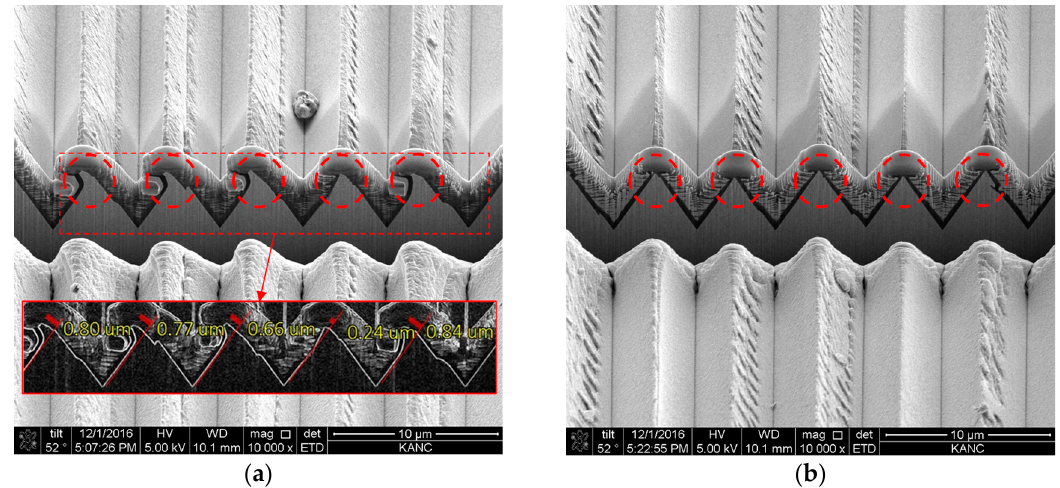
Figure 14. Machining results on the changed tool path: ( a ) the machining result obtained by using the tool path shown in Figure 6a, and ( b ) the machining result obtained by using the tool path shown in Figure 6b.